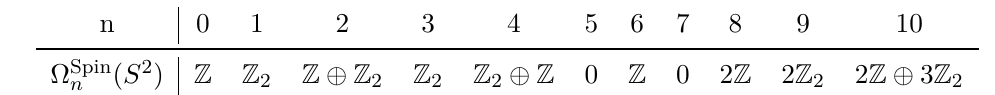
( S 2 ) , n = 0 , . . . , 10 , up to extensions. n